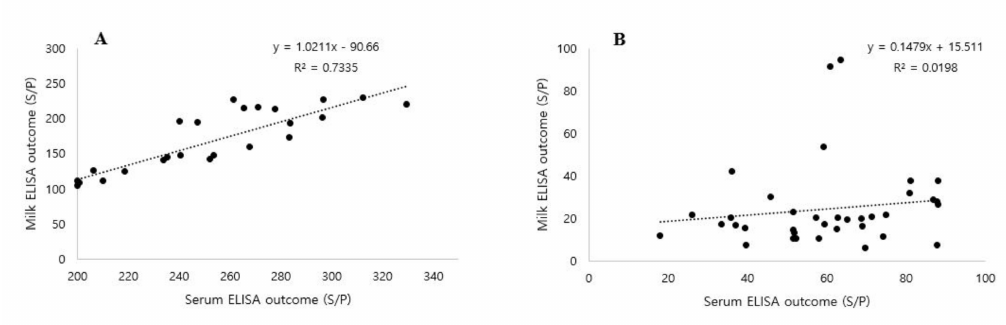
Figure 3. The correlation between the outcome of serum and milk ELISA results in high and low serum MAP antibody titer. ( A ) High serum MAP antibody titer ( > 200) with an R 2 of 0.7335 ( p ≤ 0.00). ( B ) Low serum MAP antibody titer ( < 100) with an R 2 of 0.0198 ( p ≤ 0.00). Each dot reflects 1 milk and serum